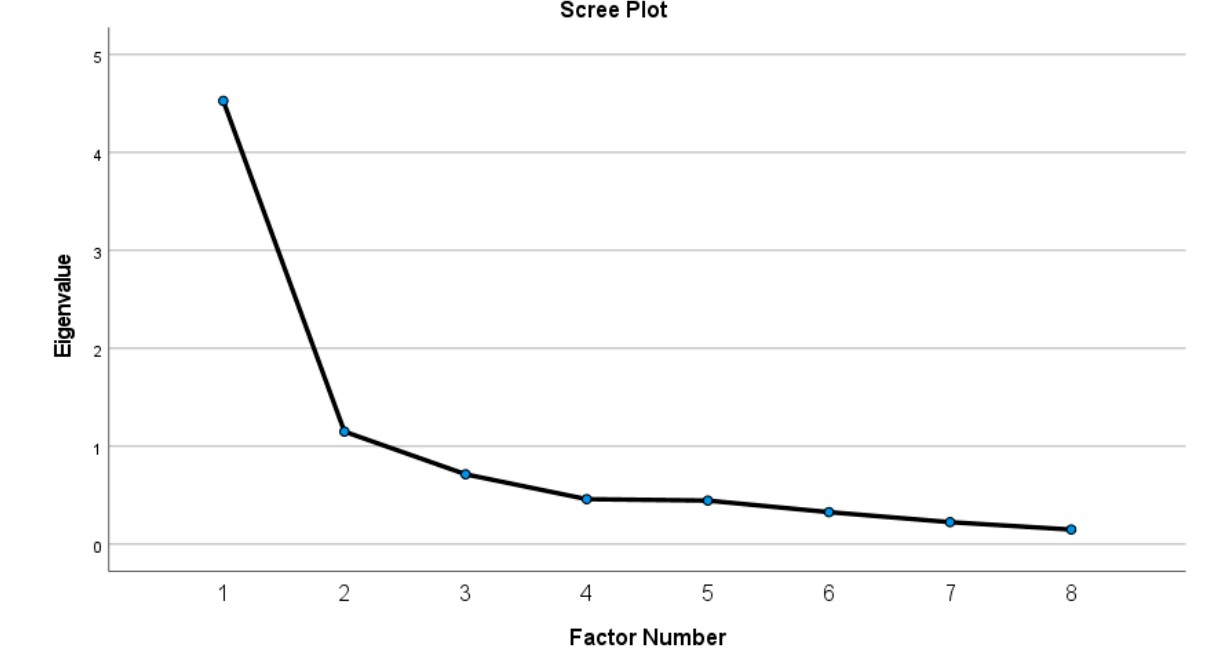
Figure 1. Scree Plot for Exploratory Factor Analysis. Proficiencies of soil and nutrient management competencies were analyzed using a factor matrix. Factor one consisted of eight items with factor loadings ranging from 0.54 to 0.88 and explained 52.03% of the variance. Factor two consisted of five items with factor loadings ranging from − 0.44 to 0.35. and explained 61.39% of the variance (see Table 9). Table 9. Factor loadings and proficiency items of soil and nutrient management competencies.